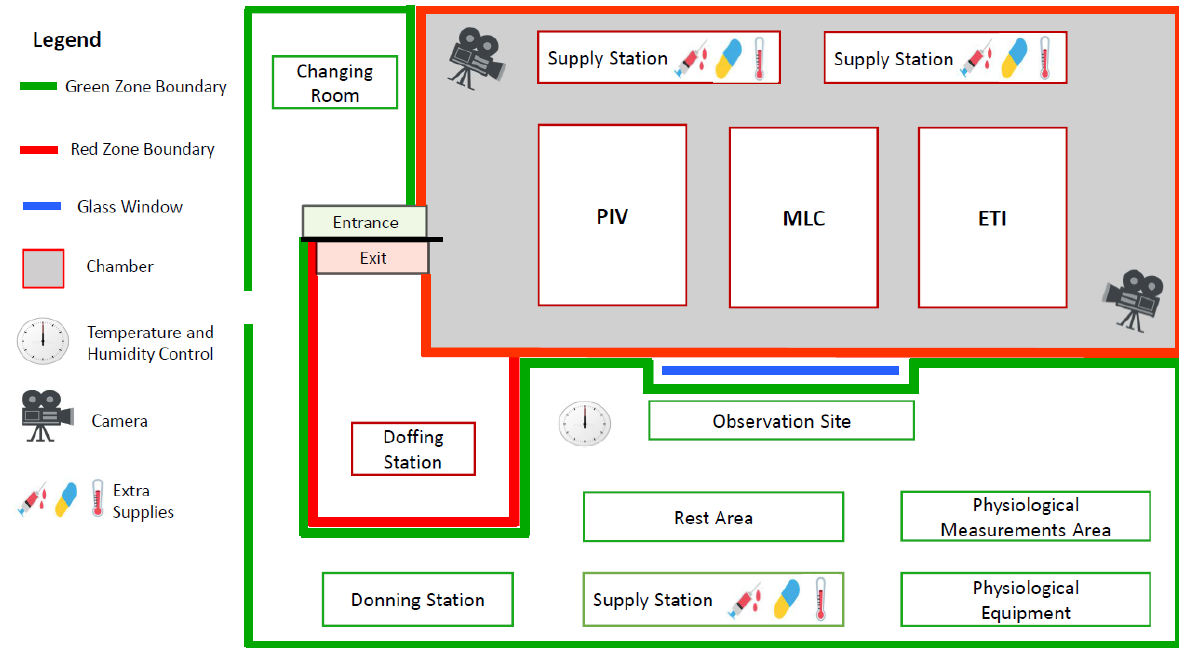
Figure 1. Layout of the simulated Ebola Treatment Unit (ETU). The red zone was divided into the suspect ward (2 beds for suspected Ebola Virus Disease (EVD) patients) and the confirmed ward (1 bed for a confirmed EVD patient), delineated by red and yellow marking tape on the floor. Participants moved unidirectionally from the green zone to red zone, and from the suspected ward (with 2 patients requiring PIV and MLC) to the confirmed ward (with 1 patient requiring ETI) within the red zone. The supply stations in the red zone contained extra supplies for the 3 tasks; additional clean supplies were stored in a green zone supply station. The climate-controlled chamber had only 1 door; in an actual ETU, the entrance to the green zone and the exit from the red zone would be separated. PIV, peripheral IV; MLC, midline catheter; ETI, endotracheal intubation.